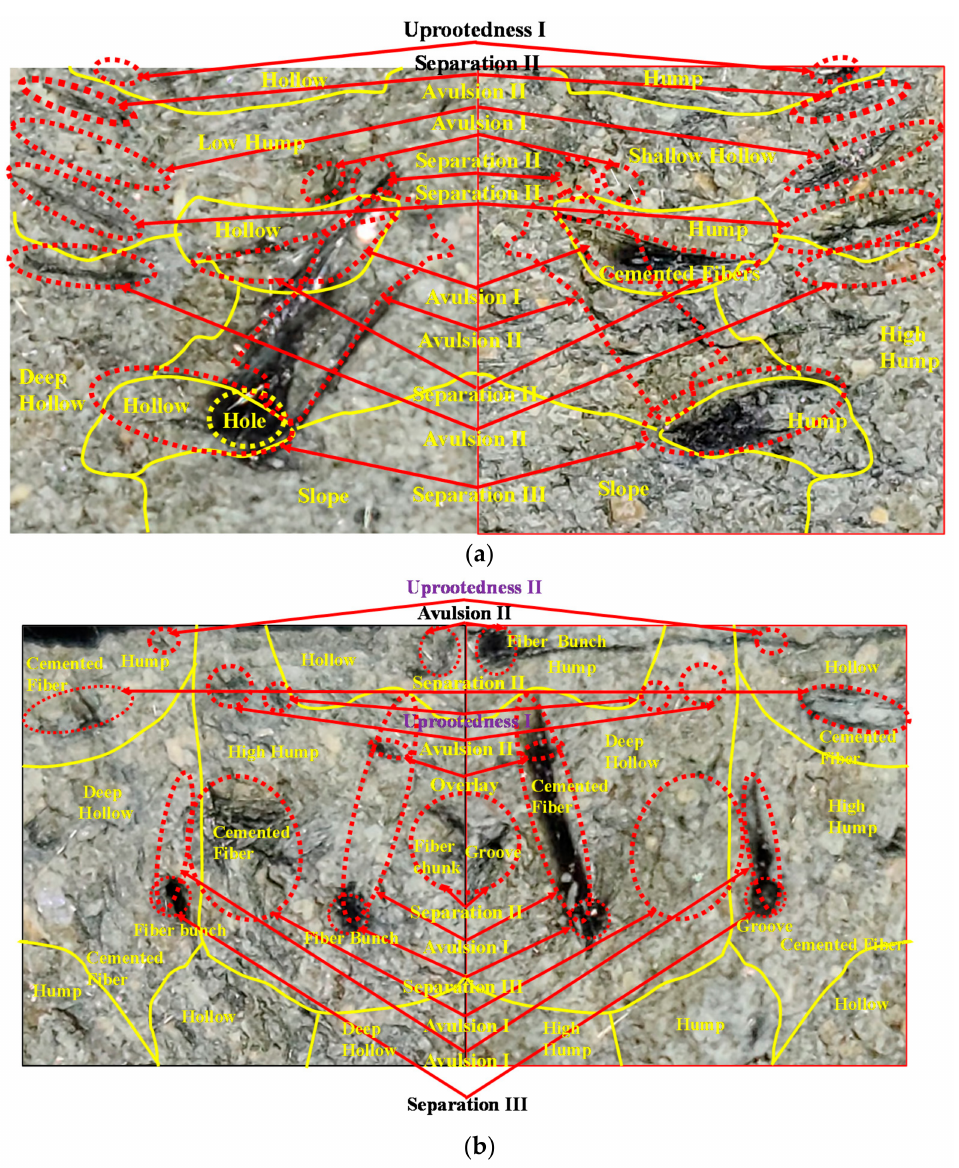
Figure 11. Fiber traces on the cracked surfaces of CF 2.0. ( a ) CF 2.0-1, ( b ) CF 2.0-2. The smaller cemented fiber bunch is found in the right side of the nearly vertically aligned cemented fiber bunch on the slope side of the high hump. The matching area in the left image shows no fiber vestige. It reveals avulsion I. In the bottom of the smaller cemented fiber cluster, another small fiber cluster in a groove is observed. Its matching area in the left image also shows a fiber cluster. It is a separation III trace. The partly cemented dark areas in the center and top right of the left side image represent fiber clusters. Their matching areas in the right image are a fiber-laden mortar and a cemented fiber cluster. Hence, they reveal avulsion I and separation II traces, respectively. The dark spots are all fiber clusters except the dark area in the top left of the left side image and the long dark line in the top right of the right side image. These are mostly not fibers but broken areas during the breaking of the prism sample into two parts due to the